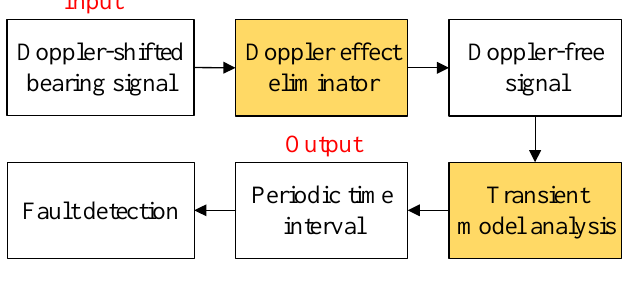
Figure 2. Flowchart of the proposed wayside bearing fault diagnosis